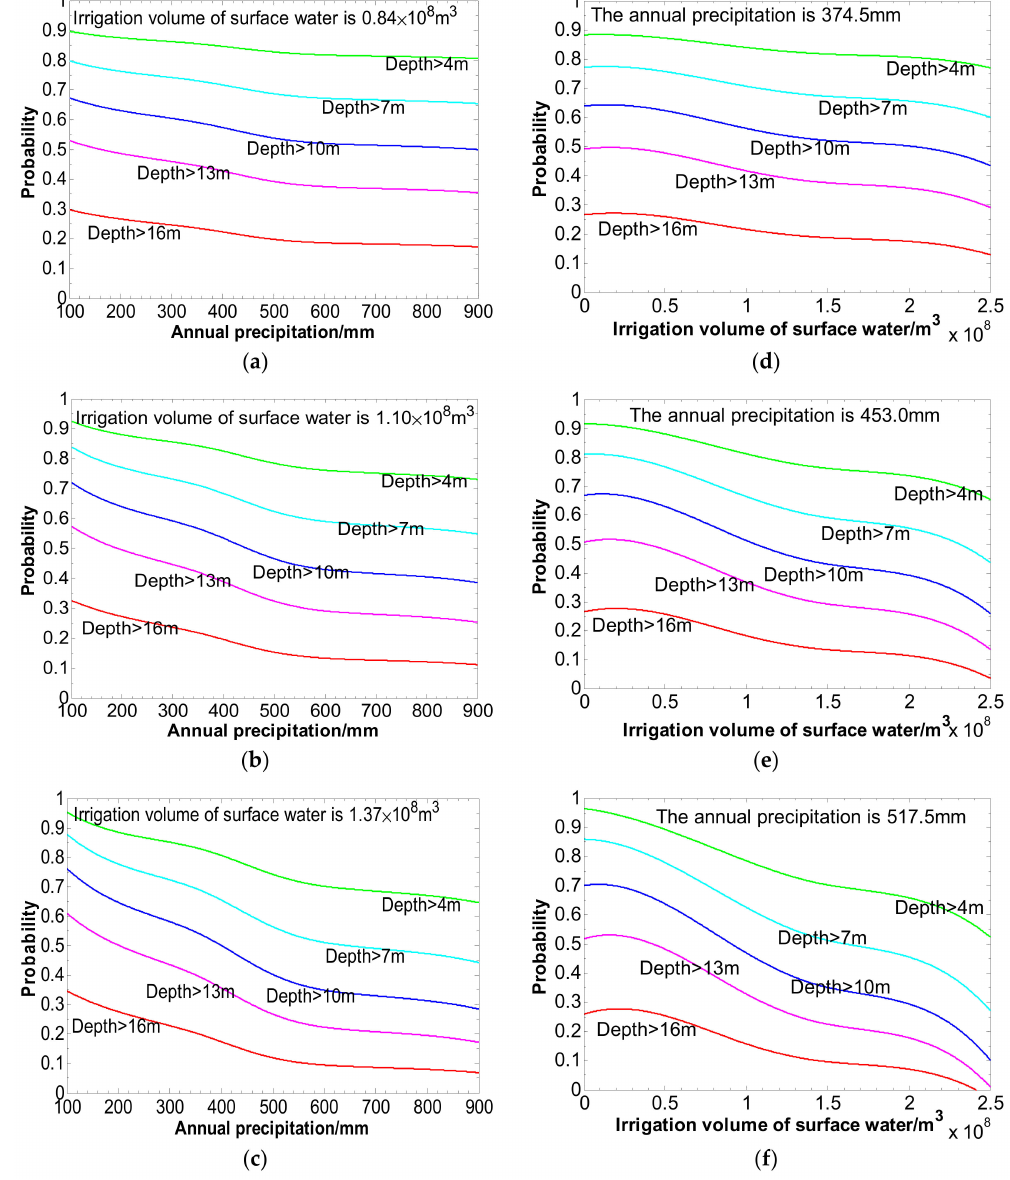
Figure 7. Conditional probability graph of the 3D Copula Function. ( a ) The value of the surface water irrigation volume is 0.84 × 10 8 m 3 ; ( b ) the value of the surface water irrigation volume is 1.10 × 10 8 m 3 ; ( c ) the value of the surface water irrigation volume is 1.37 × 10 8 m 3 ; ( d ) the annual precipitation is 374.5 mm; ( e ) the annual precipitation is 453.0 mm; and, ( f ) the annual precipitation is 517.5